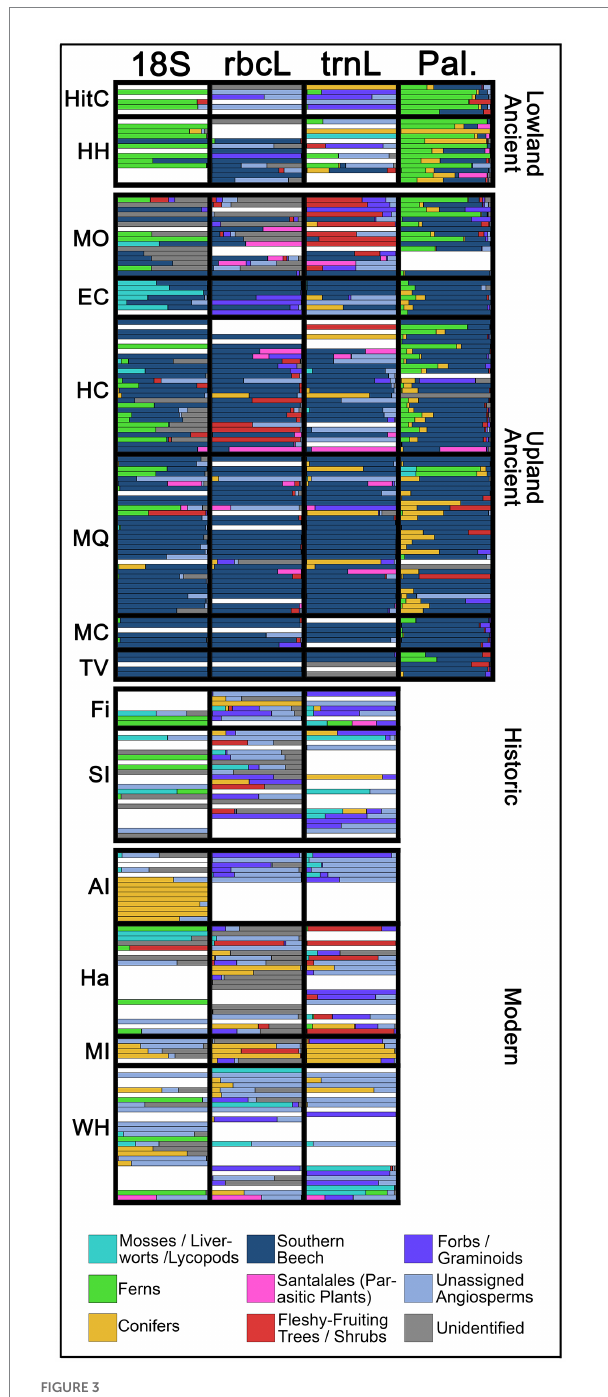
FIGURE 3 Proportion of key plant taxonomic/ecological groupings, separated by gene (for DNA data), or palynological data (counted for ancient samples only). Sites are further subdivided by age group, and ecology (for ancient samples). White spaces refer to samples that could not be sequenced for the target gene. Refer to Table 1 for site